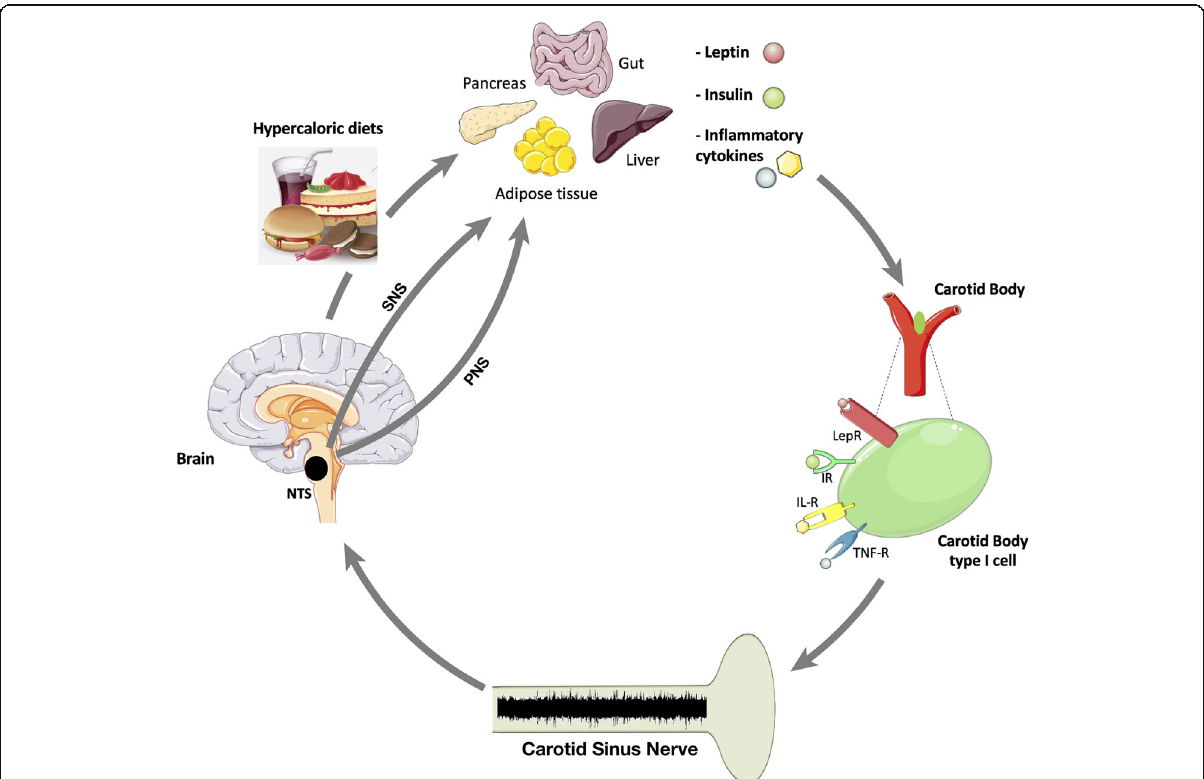
Fig. 2 Postulated link between diet-induced dysmetabolism and the brain-carotid body axis: Hypercaloric diets generate a dysmetabolic state characterized by hyperleptinemia, hyperinsulinemia and inflammation, transduced by an overexpression of inflammatory cytokines. These key mediators contribute to carotid body (CB) dysfunction that is in the genesis of metabolic diseases since all these mediators are able to activate the CB, by acting on respective receptors within the organ, and modulate its function, e.g. via the release of neurotransmitters. Carotid sinus nerve (CSN) transmit this information from CB to the central nervous system, namely to the nucleus tractus solitarii (NTS), leading to the activation of both sympathetic and parasympathetic nervous systems to the efferent organs to modulate metabolism. Also, CSN information integrated in the NTS will impair satiety control and food intake, aggravating hyperphagia. All together, these afferent stimuli (metabolic vs inflammation) and intensity of reflexes stimulation may contribute to the activation or to different degrees of activation of different